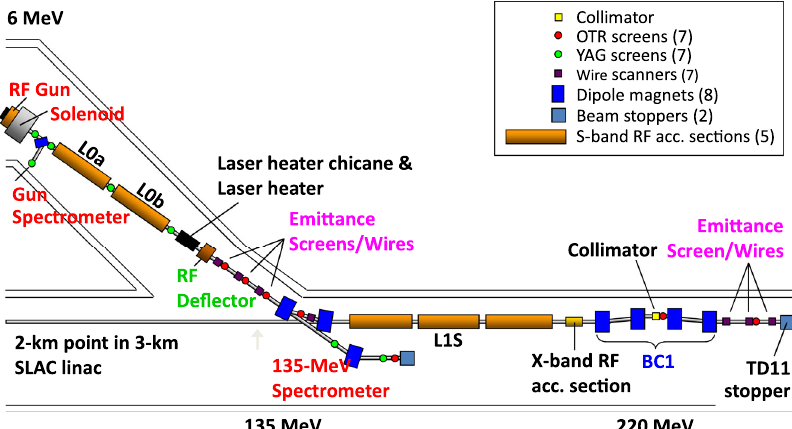
FIG. 2. Schematic layout of the LCLS injector and BC1. The horizontal collimator is located in the center of the BC1 chicane.